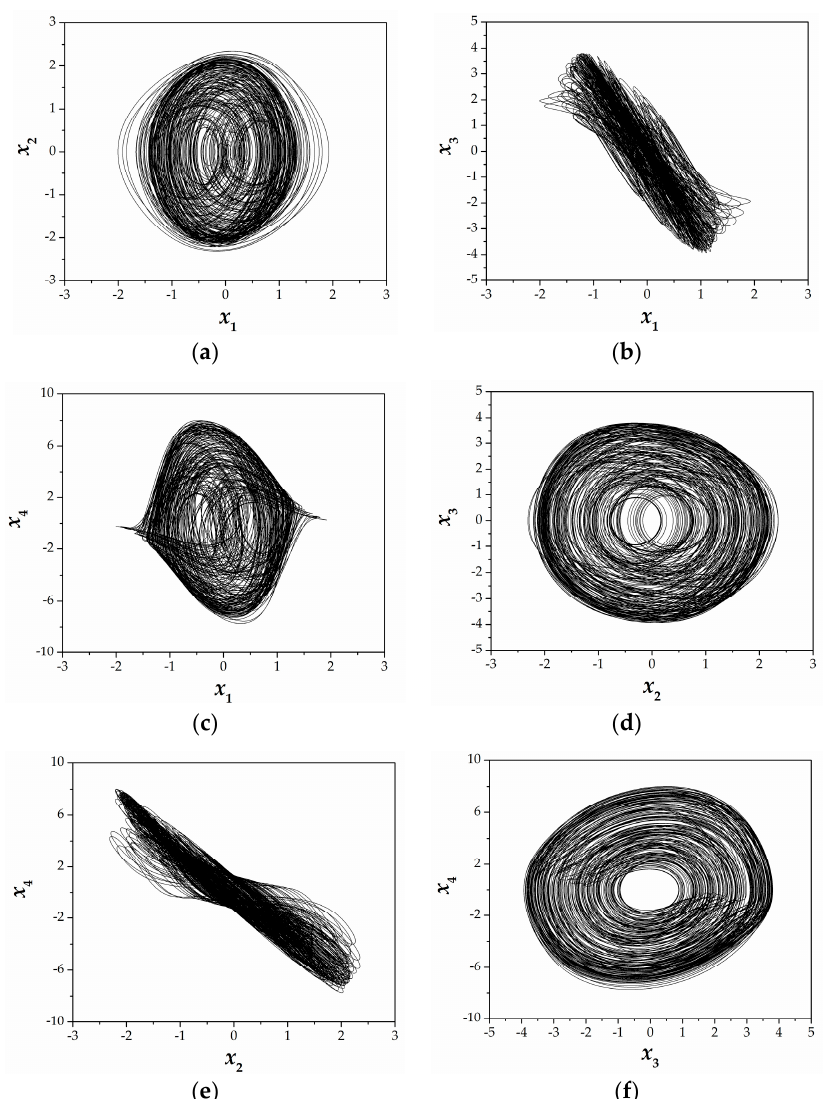
Figure 1. Hyperchaotic attractors of system (8) in ( a ) x 1 – x 2 plane; ( b ) x 1 – x 3 plane; ( c ) x 1 – x 4 ; ( d ) x 2 – x 3 plane; ( e ) x 2 – x 4 plane and ( f ) x 3 – x 4 plane, for a = 3.8, b = 0.1 and c = 1.5 and initial conditions ( x 1 (0), x 2 (0), x 3 (0), x 4 (0)) = (0.1, 0.1, 0.1, 0.1).